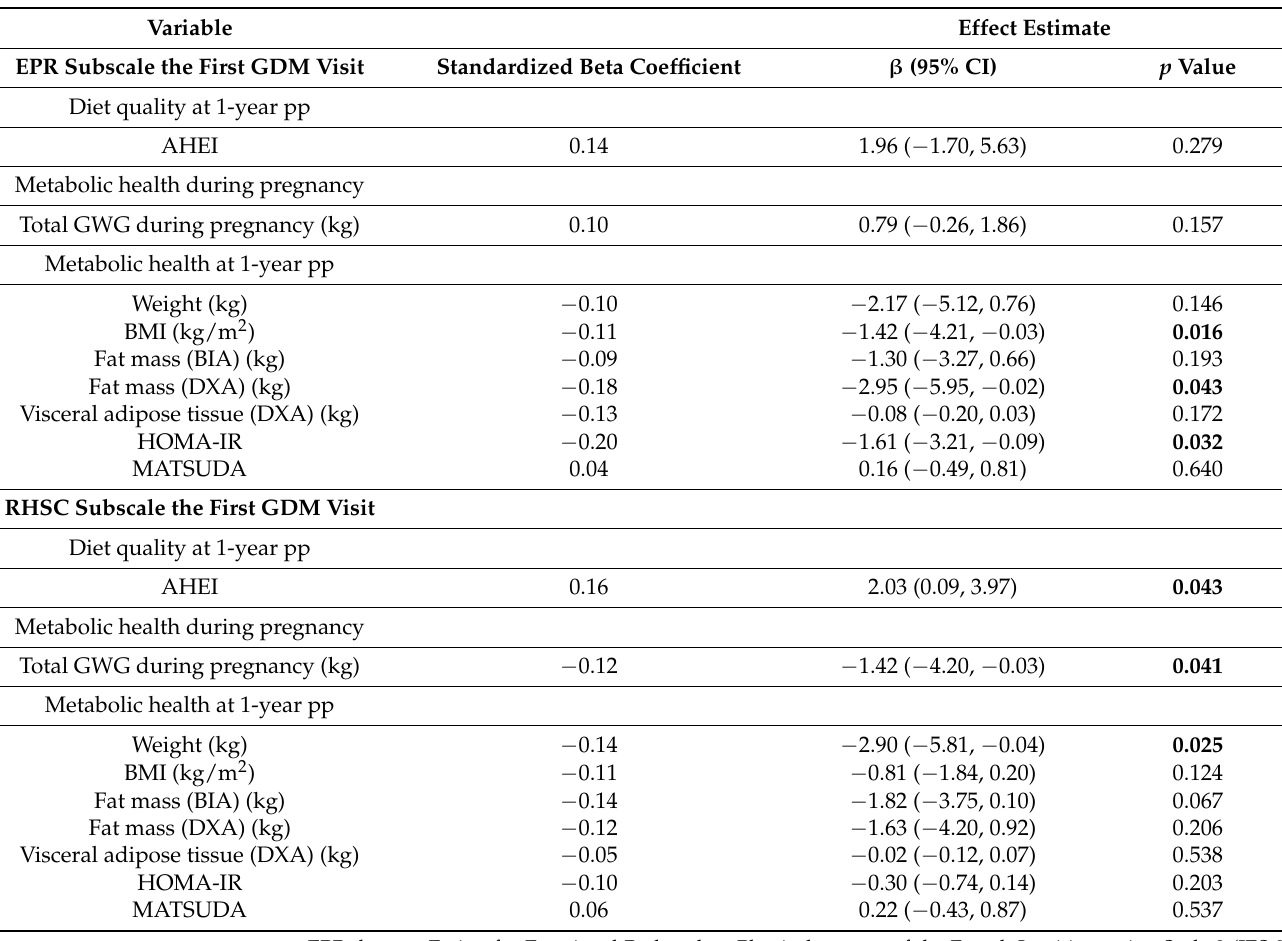
Table 4. Longitudinal associations between the two subscales of intuitive eating during pregnancy with diet quality and metabolic health outcomes up to 1-year postpartum.